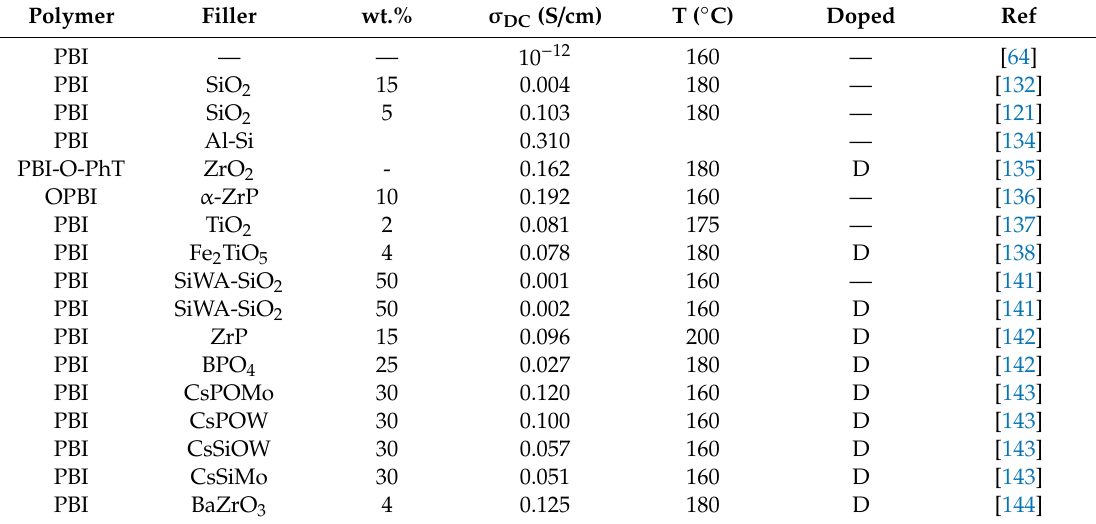
Table 7. Composite membranes of polybenzimidazole derivates with inorganic materials. Polymer